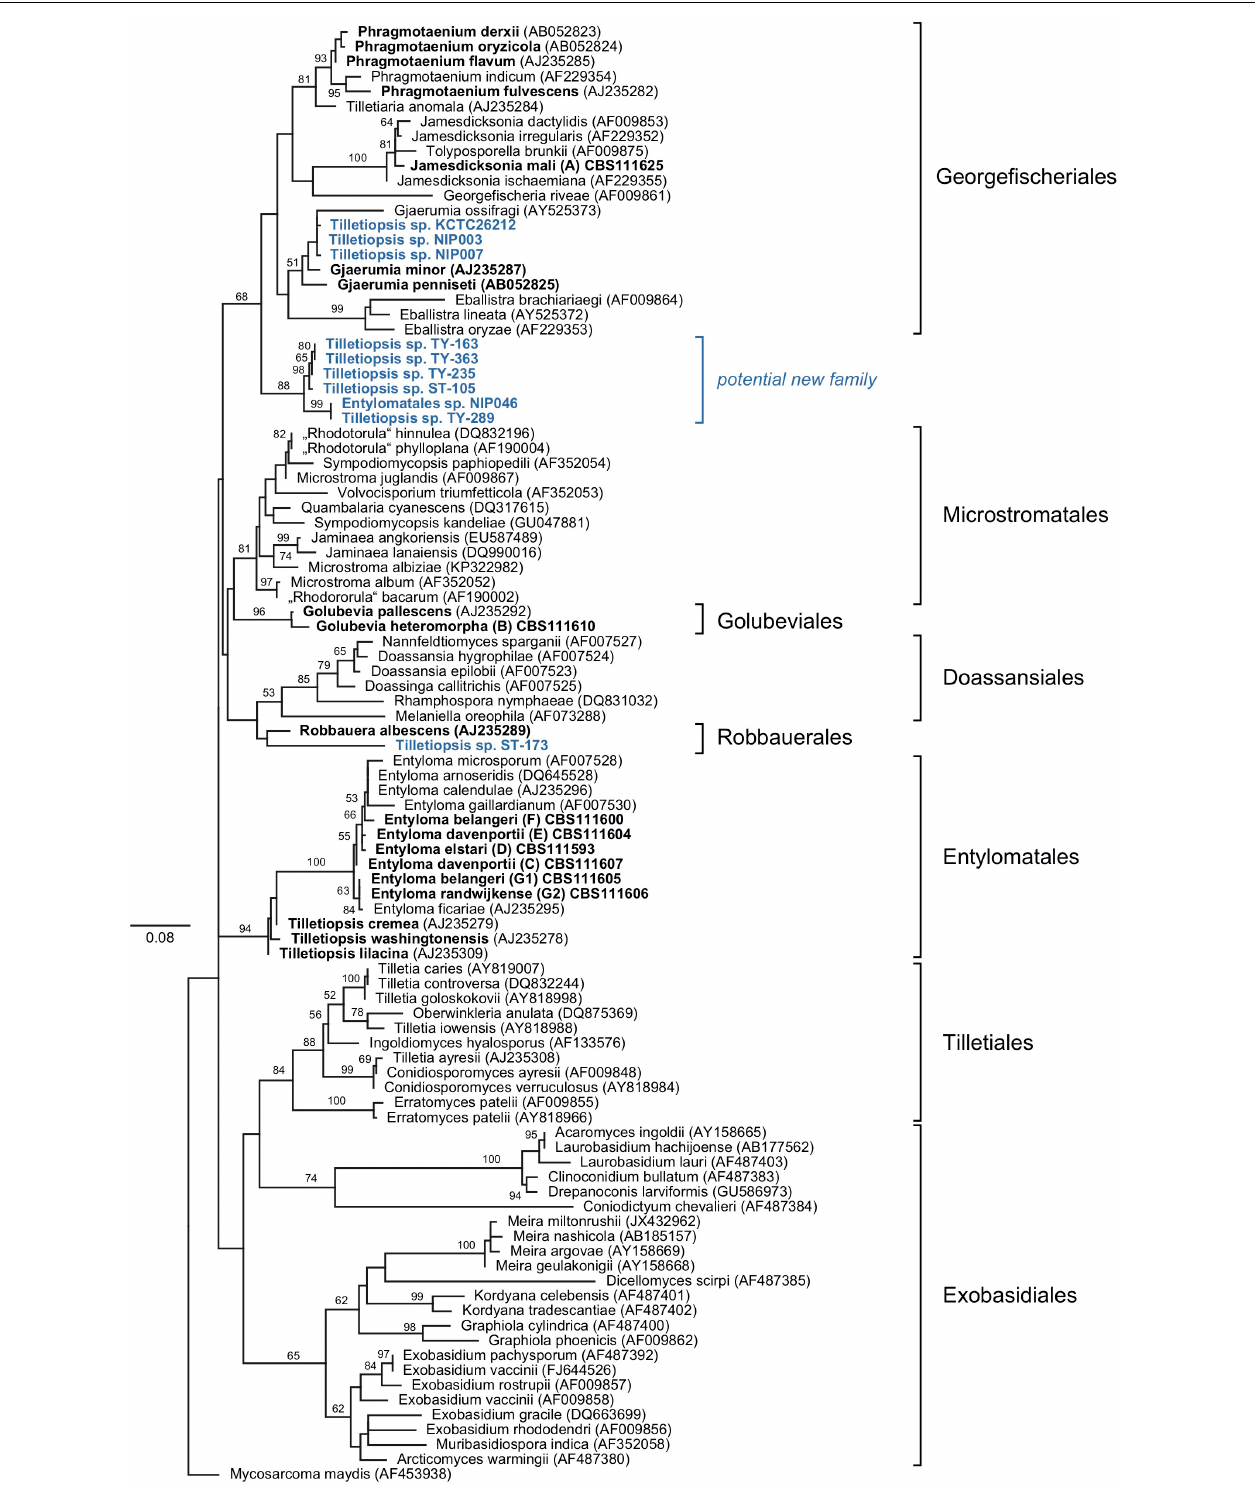
FIGURE 2 | Diversity of Tilletiopsis -like fungi determined with Maximum Likelihood analysis of the LSU rRNA gene (D1/D2 domains). The numbers on branches are frequencies ( > 50%) with which a given branch appeared in 1000 bootstrap replications. The scale bars indicate the numbers of expected substitutions accumulated per site. Nucleotide sequences of Tilletiopsis -like fungi are in bold. Potential new species are given in blue color.